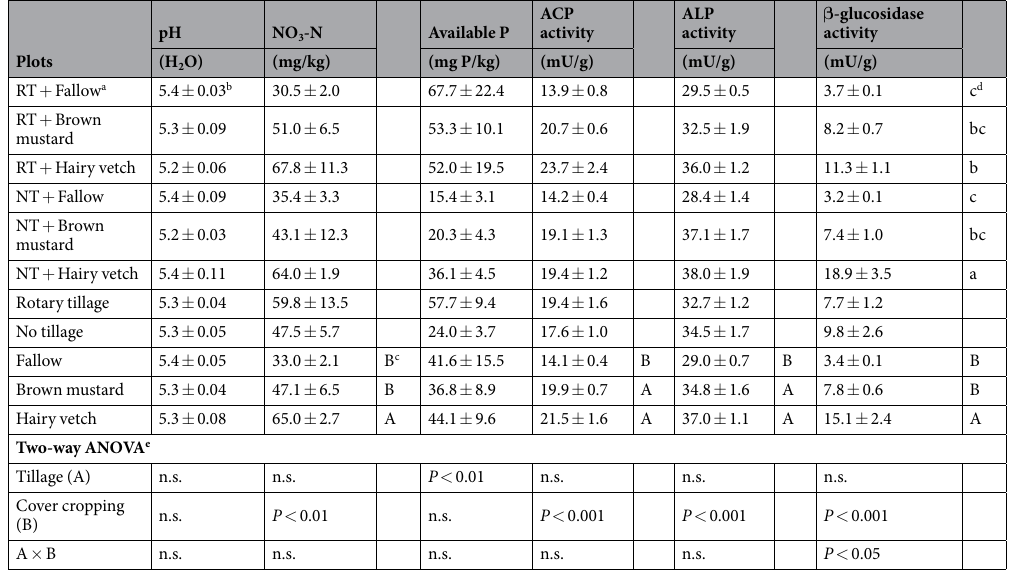
Table 2. Influence of cover crops and tillage management on the soil biochemical properties before planting maize. a RT: rotary tillage. NT: no tillage. b Means ± standard errors. c Different capital letters within the same column for NO 3 -N content, activities of acid, alkali phosphatase and β -glucosidase among mean values of three cover crop types indicate significant differences at the 5% level by the Tukey test. d Different lower letters within the same column for β -glucosidase activity among each treatment indicate significant differences at the 5% level by the Tukey test. e A significant difference at the 5%, 1% and 0.1% levels by cover cropping and tillage practices were explained by two-way analysis of variance. All analyses were run in the software environment RStudio (Version 1.2.1335 – © 2009–2019 RStudio, Inc.)